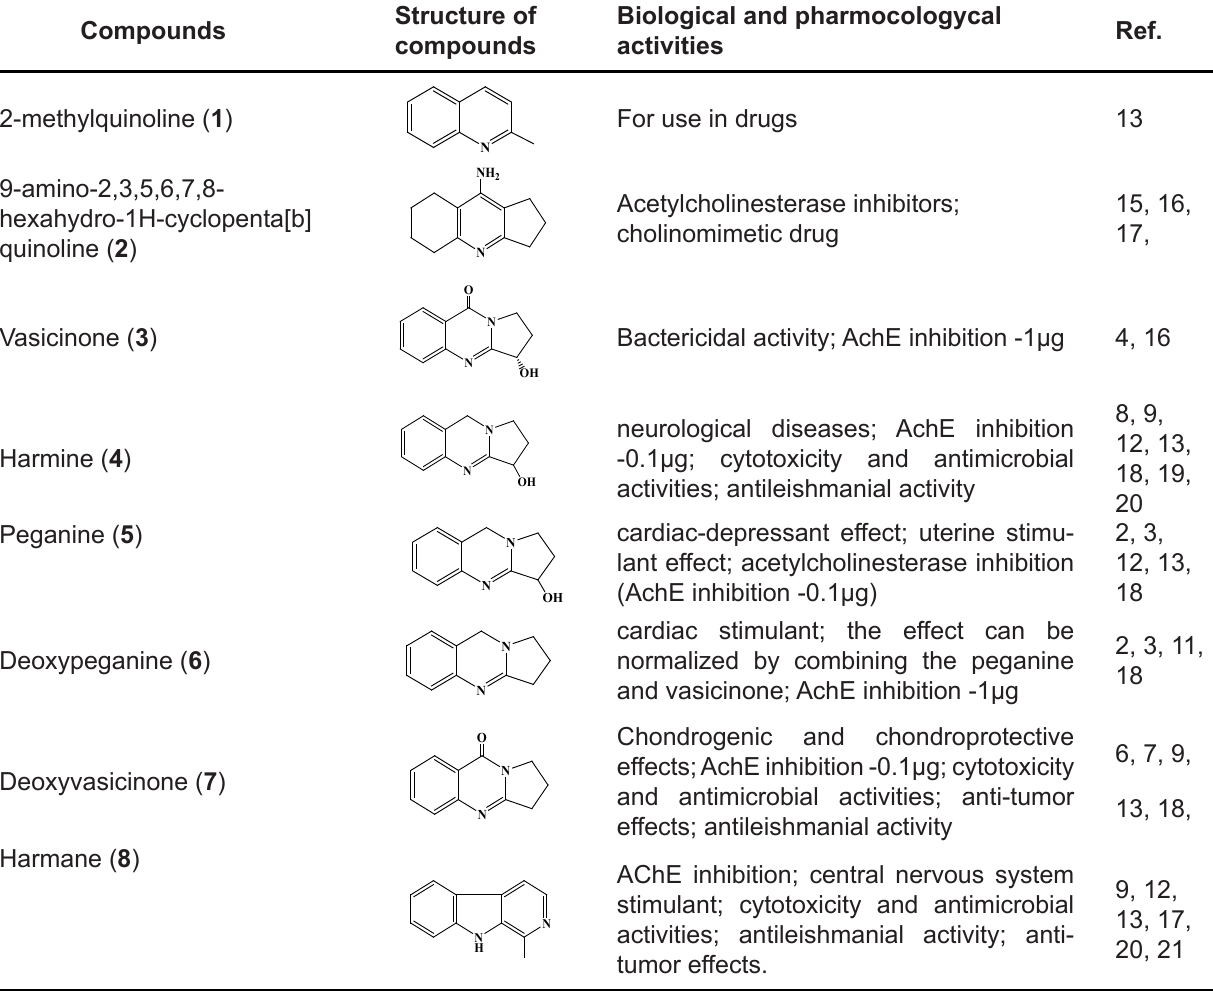
Table 4. Biological and pharmacological activities of alkaloids found from Peganum multisectum (Maxim)